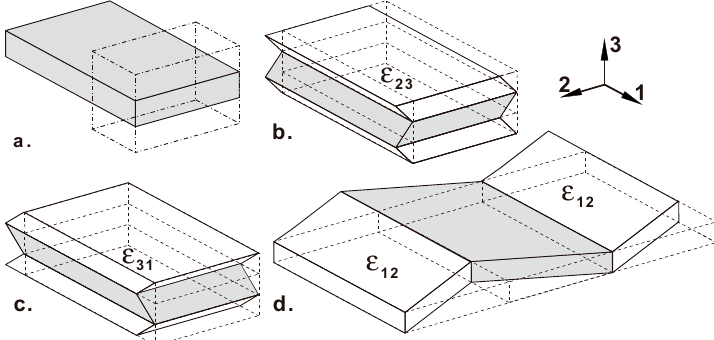
Figure 4. Shear strains ε ij that may be produced in a gray grain during rolling while considering the manner of strain compensation.